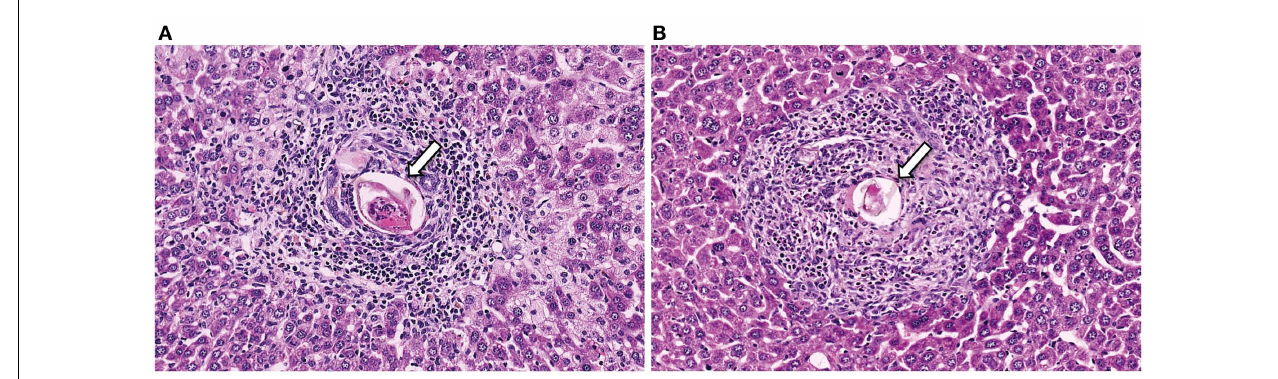
FIGURE 1 | Representative histology sections (stained with H&E) of livers from a CD4 + T cell depleted (A) and normal (B) mouse, with arrows to indicate the S. mansoni